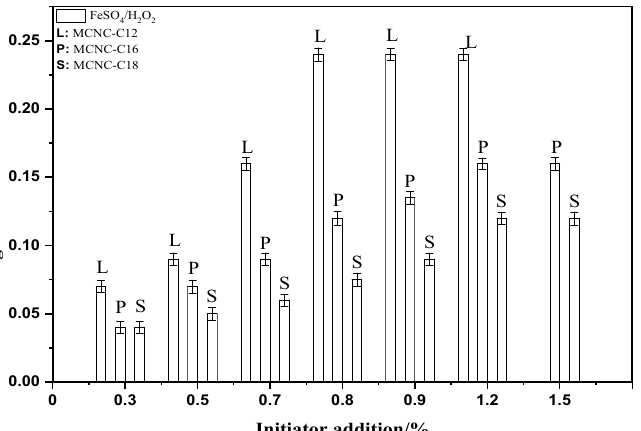
Figure 2. Effect of initiator type and dosage on substitution degree of MCNC. (MCNC-C12: MCNC grafted with lauric acid; MCNC-C16: MCNC grafted with palmitic acid; MCNC-C18: MCNC grafted with stearic acid.)